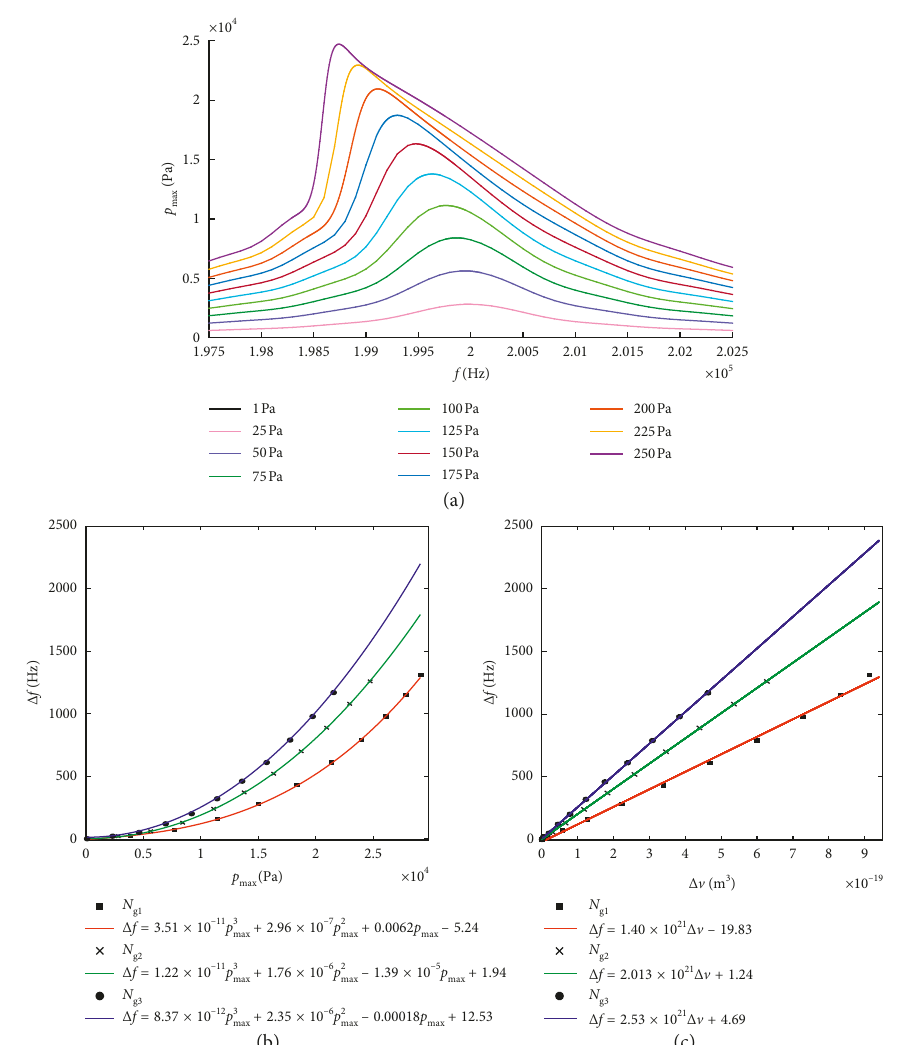
Figure 6: Maximum pressure in the cavity p frequency shift Δ f vs. pressure amplitude p